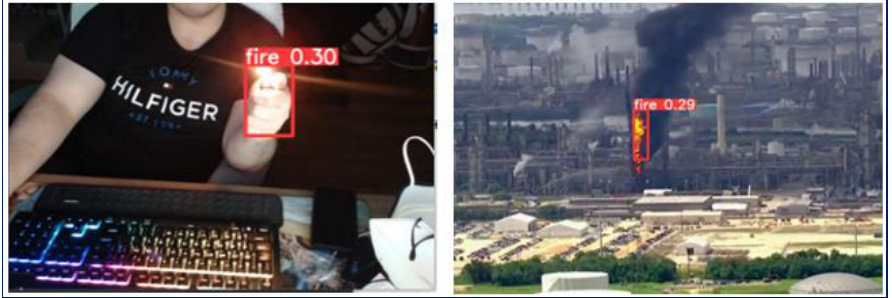
Figure 6. Small size fire region detected images.